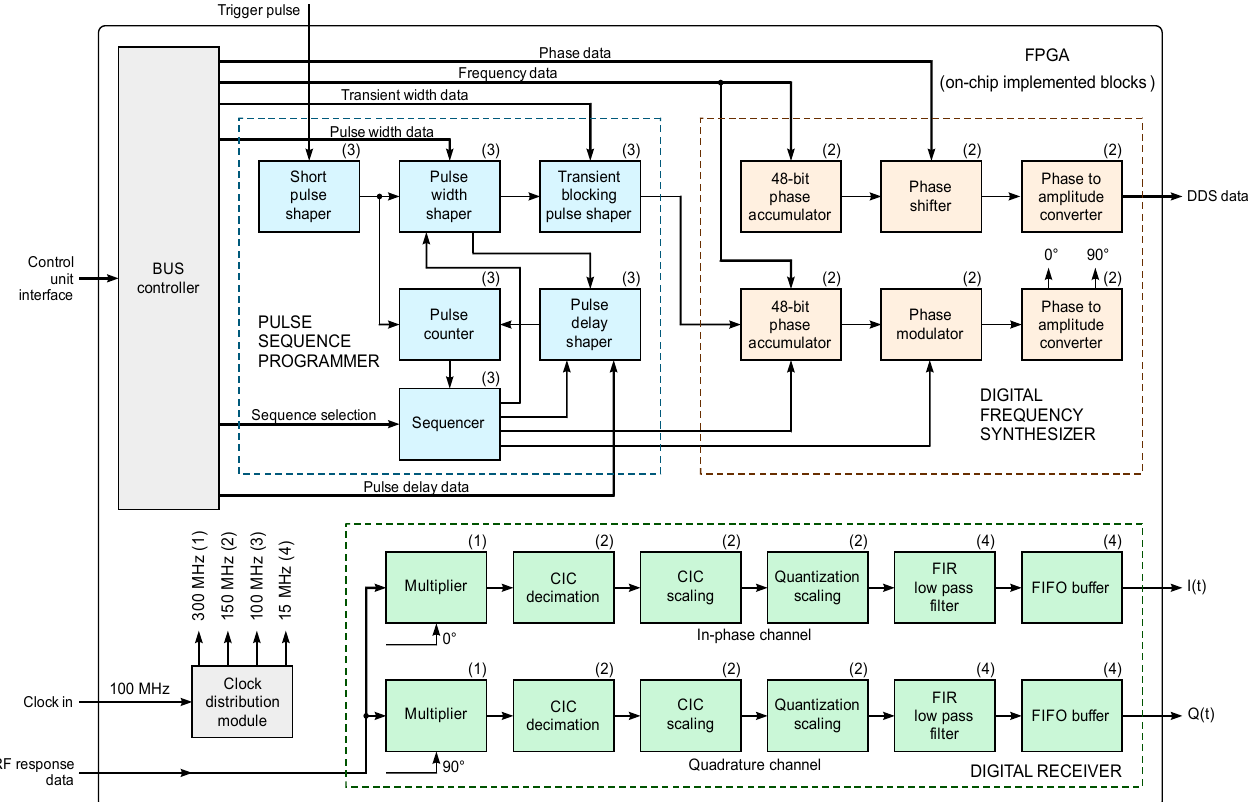
Figure 2. Overall block diagram of FPGA (on-chip implemented blocks).